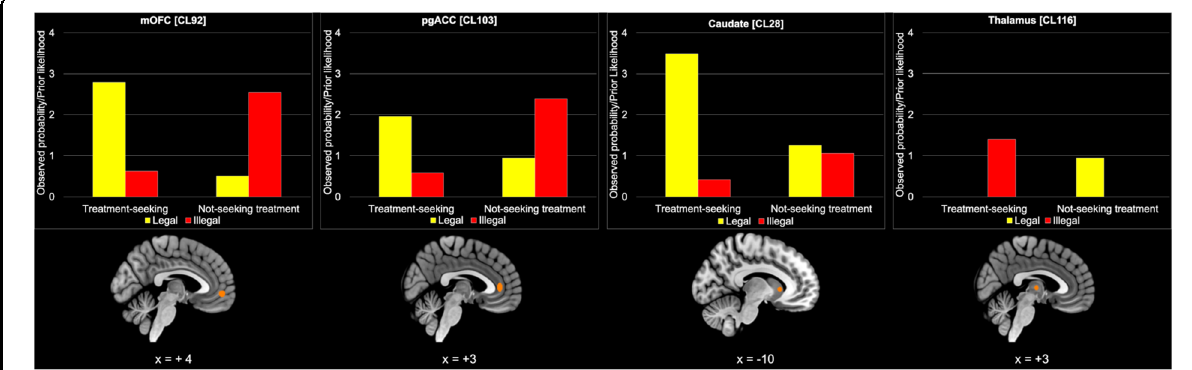
Fig. 3 Results of Fisher ’ s Exact test for the “ class of substances ” -by- “ treatment status ” interactions. Clusters with a signi fi cant class of substances-by-treatment status interaction are shown in orange, along with their respective plot. On the y axis of the bar-plots is represented the ratio between the observed probability and the prior likelihood: the more this value exceeds 1, the more the cluster is associated with that combination of factors. The decoder function of Neurosynth returned the following 15 terms with the highest association with the CCA map (decreasing order): engagement, referential (self), value, reward, traits (personality), choose, arousal, task positive, autobiographical, monetary, moral (decision making), contexts, monetary incentive, expectations, valence. Slice coordinates are reported in MNI stereotaxic space. pgACC perigenual anterior cingulate cortex, mOFG medial orbitofrontal